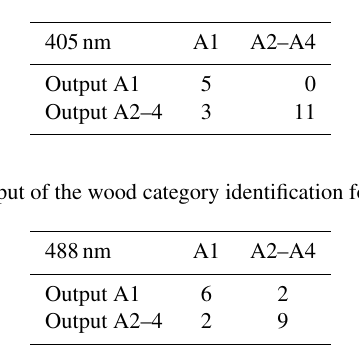
Table 3. Results of the individual tests of the wood category identification. Partial test 405nm Accuracy Precision Recall Accuracy Precision Recall Defined range of phase decay time Defined range of modulation decay time Defines standard deviation of phase decay time